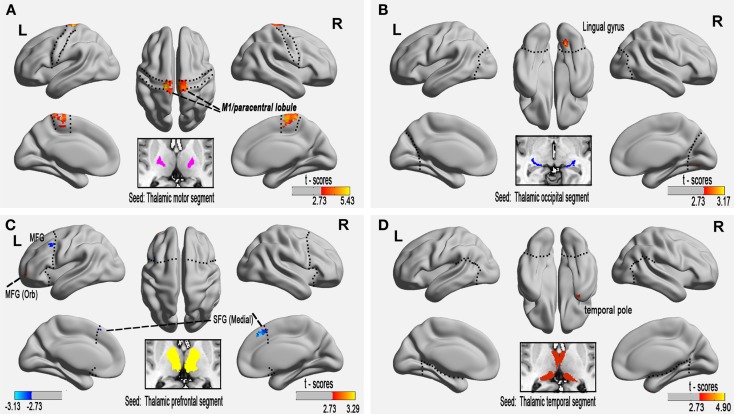
Altered functional connectivity of the paired thalamic segment and exclusive cortical regions in relapsing-remitting multiple sclerosis (RRMS) patients at the voxel level (P < 0.01, AlphaSim-corrected). (A) The connectivity-defined region (CDR) and the exclusive cortical region (ECR) of the motor cortex, (B) occipital CDR–ECR, and (D) temporal CDR–ECR show only increased FC in RRMS patients. (C) Co-existing increased and decreased FC of the prefrontal CDR-ECR in RRMS patients.